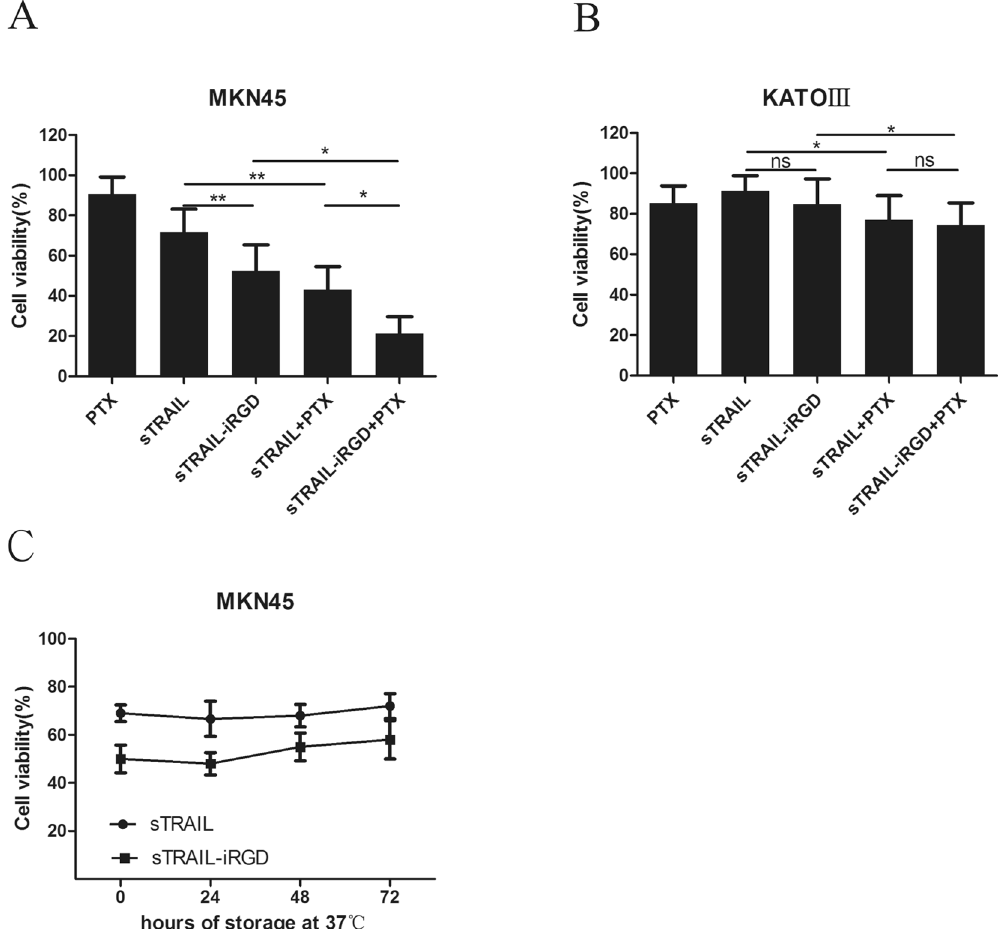
Figure 3. sTRAIL-iRGD + PTX cytotoxicity in tumor cell lines. sTRAIL-iRGD or sTRAIL combined with PTX were added to MKN45 ( A ) and KATOIII ( B,C ), comparison of the stability of sTRAIL-iRGD. MKN45 cells were treated with sTRAIL-iRGD and sTRAIL that was stored for either 24, 48 or 72 h prior treatment at 37 °C. Cell suspensions and incubated for 24 h. Cell viability was measured by MTT assay. All data are expressed as means ± standard deviation (SD), n = 3, and represent the means of three independent experiments. Statistical analyses were performed using the Student t-test and one-way ANOVA. * p < 0.05; ** p < 0.01; ns, not